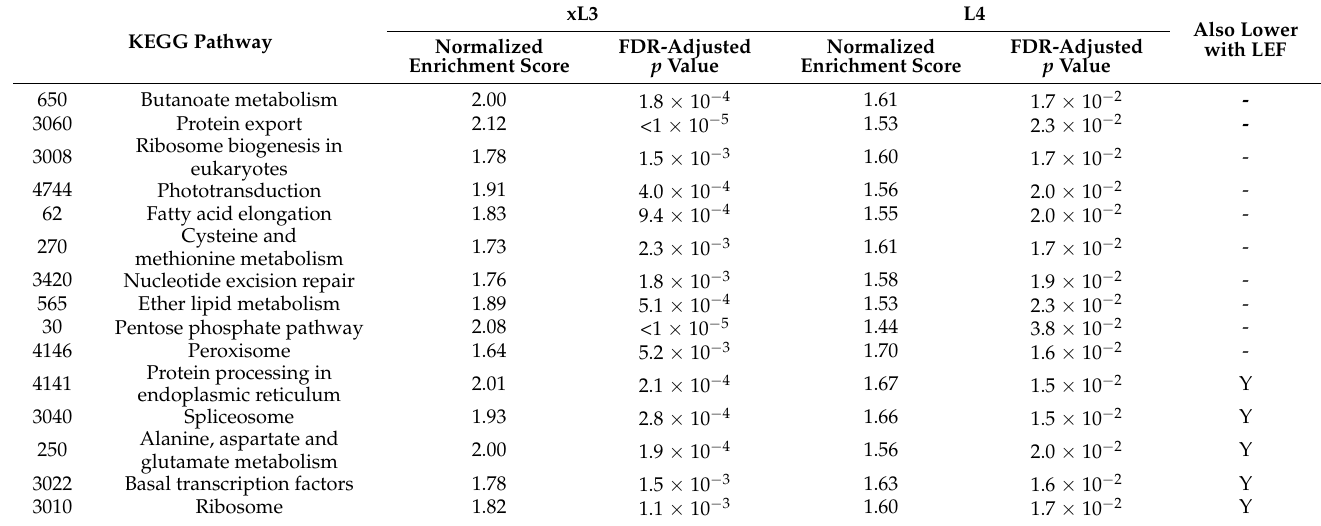
Table 4. Top 15 KEGG pathways most significantly downregulated in both xL3 and L4 H. contortus in response to Staurosporine